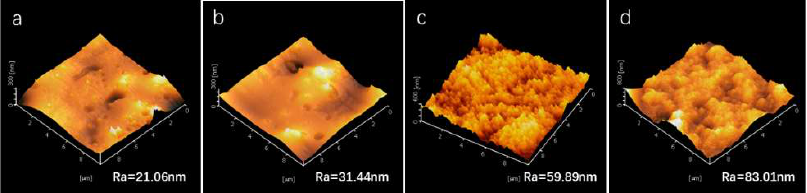
Figure 6. Roughness measurements of hydrophobic coatings with silica content of 10%, 20%, 30%, and 40% are illustrated in ( a – d ). These measurements were obtained by AFM, and the average mean square roughness values (Ra) of coatings with silica content of 10%, 20%, 30%, and 40% are 21.6 nm, 31.44 nm, 59.89 nm, and 83.01 nm, respectively.